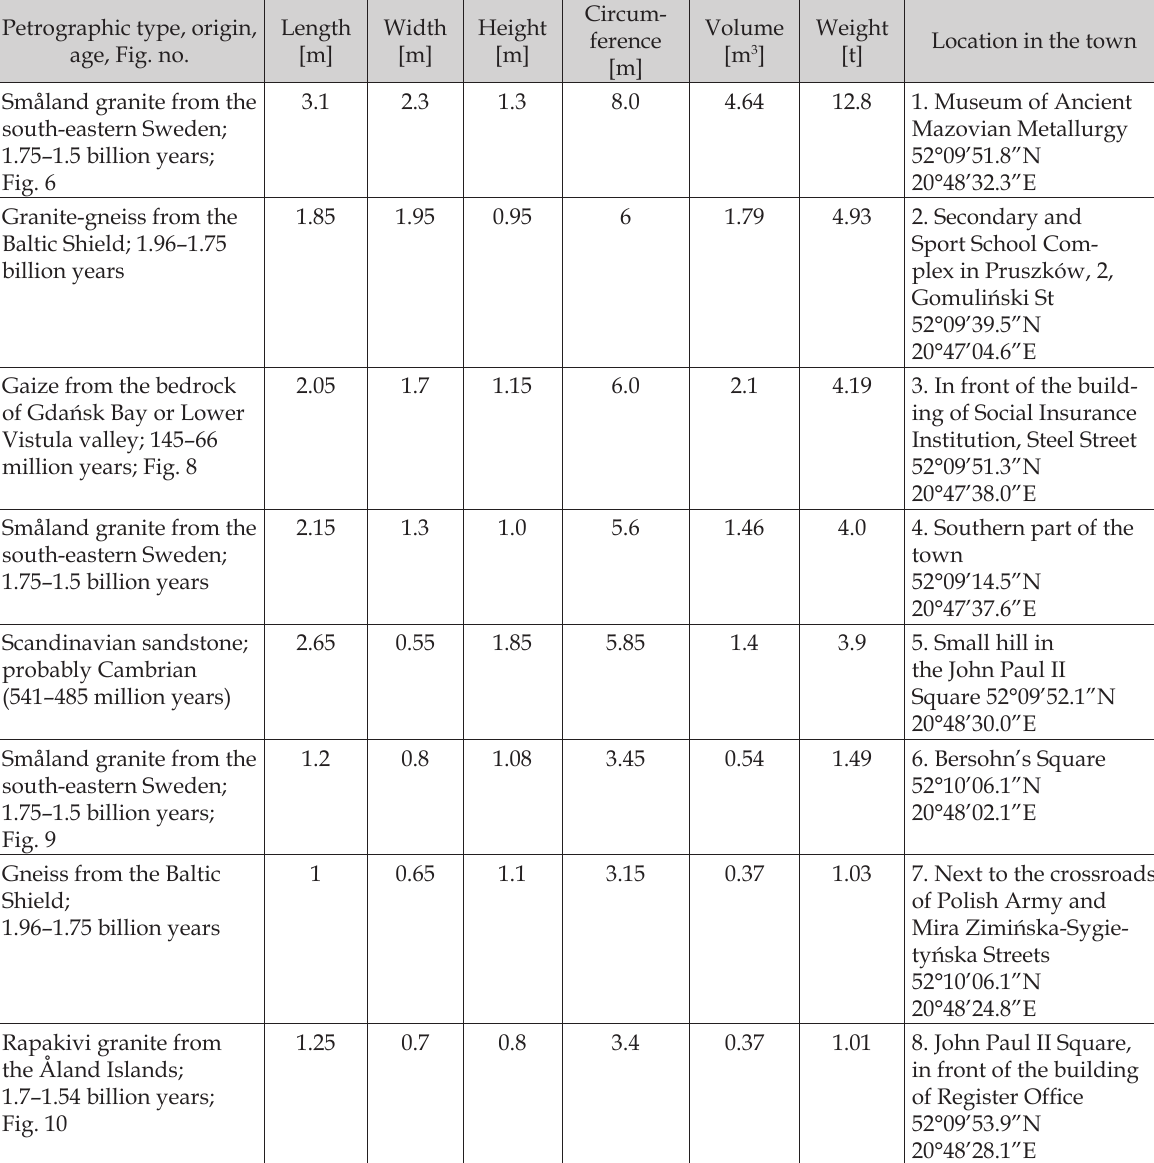
Table 2. List of the eight largest erratics in